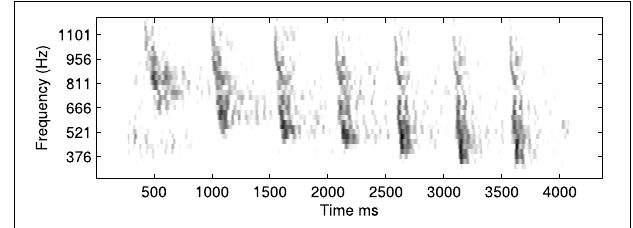
FIGURE 12 | An example of a natural communication call, in this case a Weddle Seal, shown here as a spectrogram. This pattern was used to derive the predicted learning patterns shown in Figure 13